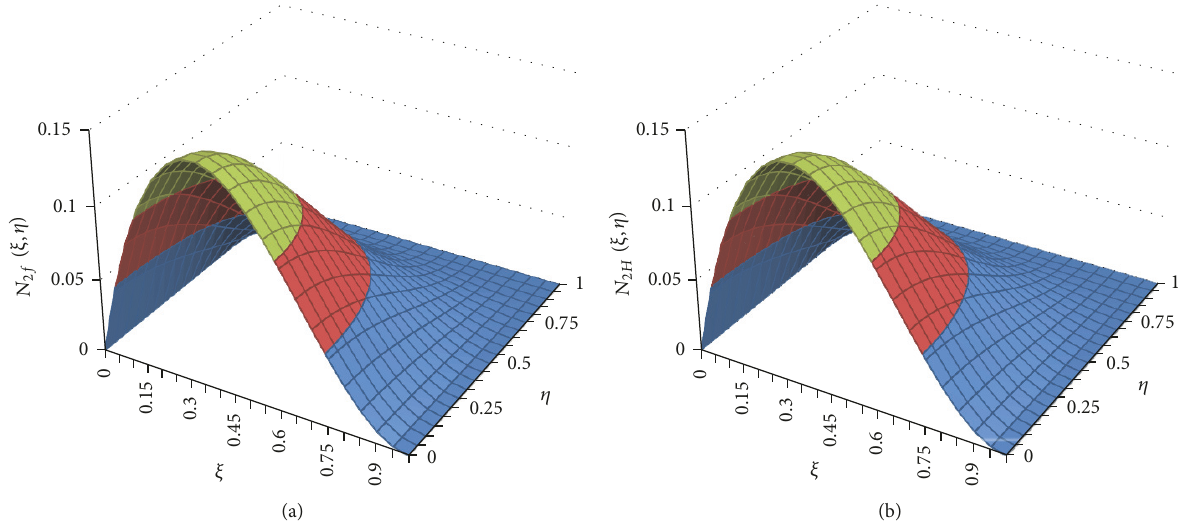
Figure 3: DFE (a) and FEM (b) shape function for 𝜃 𝑥1 at node